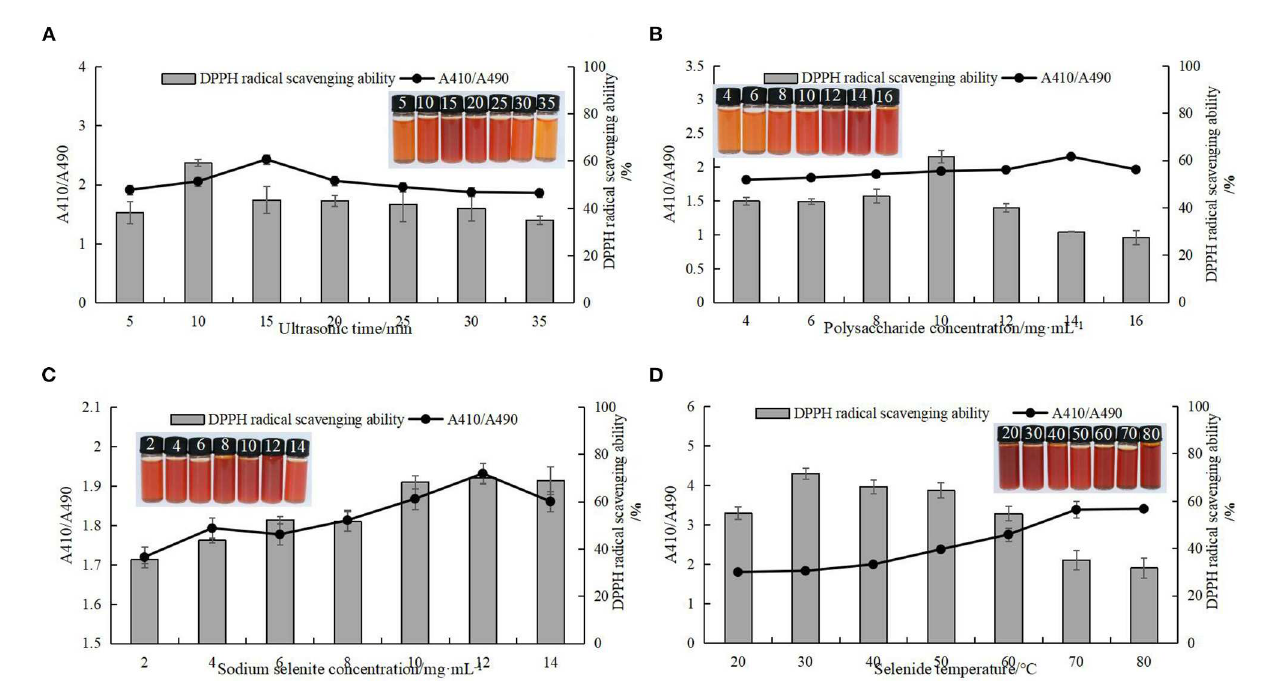
FIGURE11 Stability of selenated chestnut polysaccharide and DPPH free radical scavenging ability (A) ultrasonic time (B) polysaccharide concentration (C) sodium selenite concentration (D) selenation